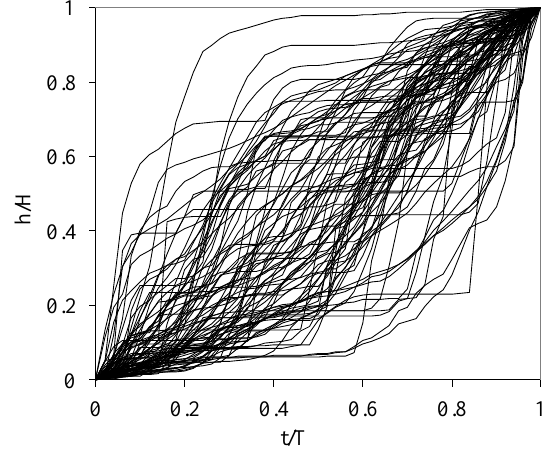
Figure 4. Historical normalised mass curves derived for all the events selected.